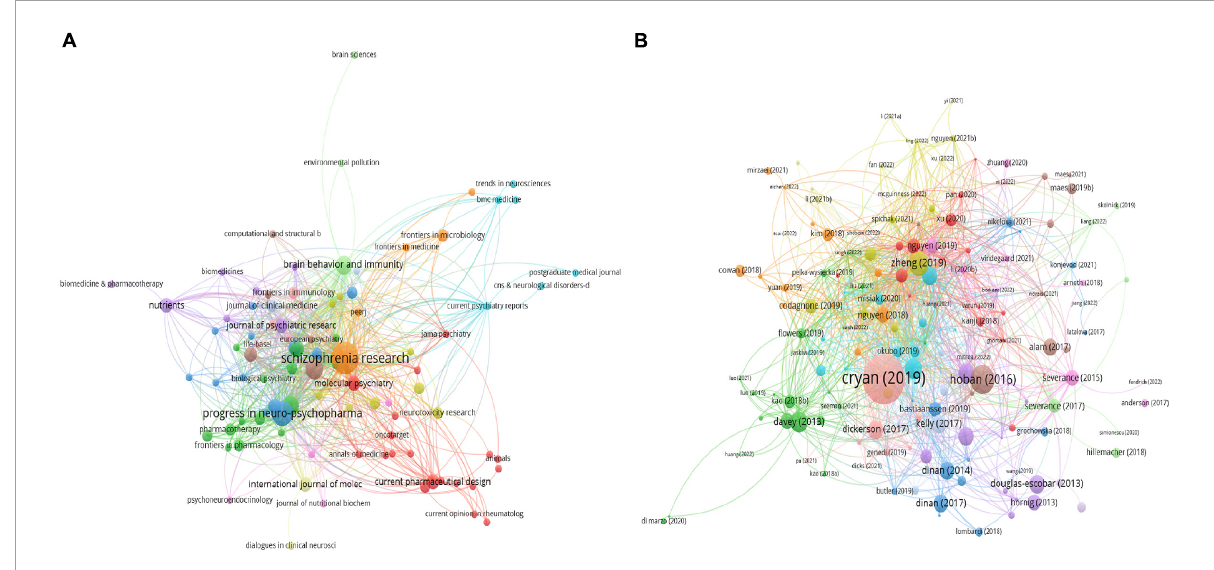
FIGURE4 Visualization knowledge maps of citations. (A) Journals. (B)